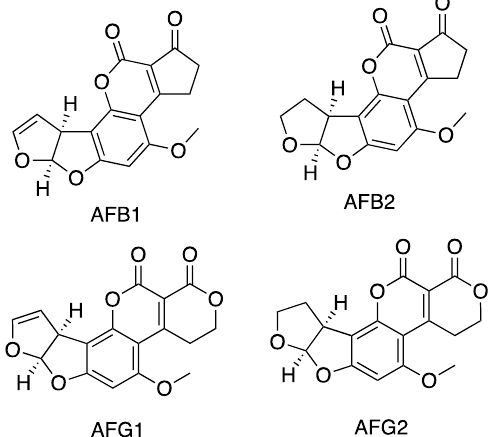
Figure 1. Chemical structure of the main aflatoxins: AFB 1 , AFB 2 , AFG 1 , AFG 2 .